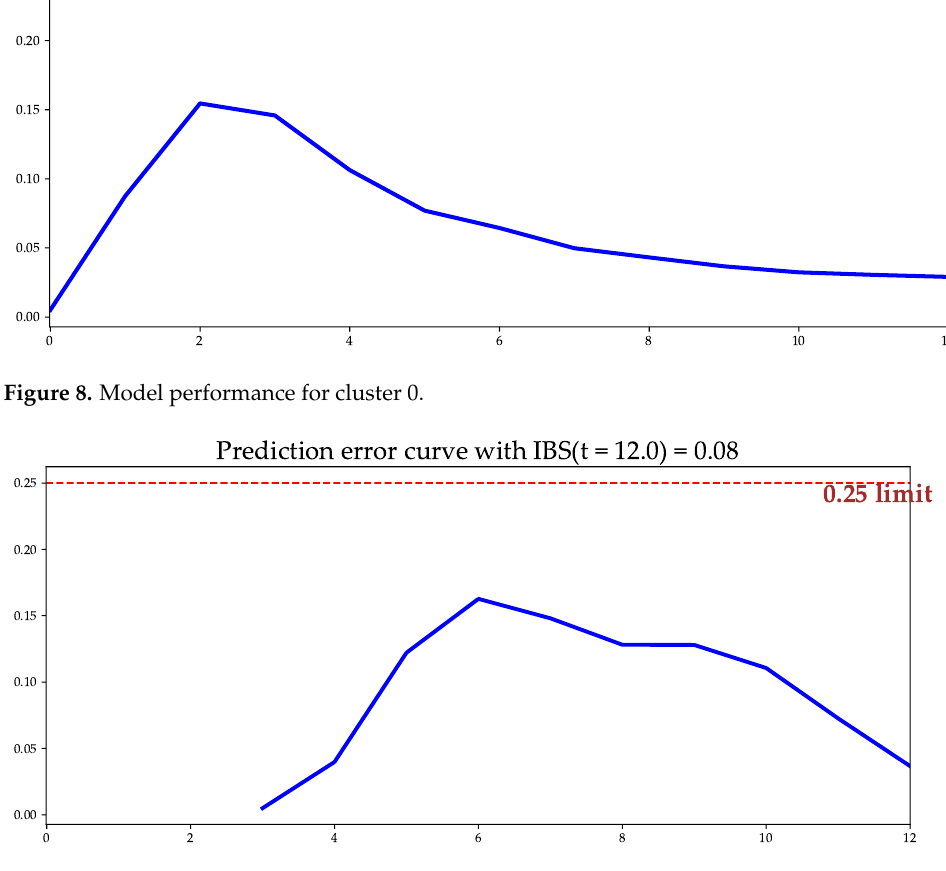
Figure 9. Model performance for cluster